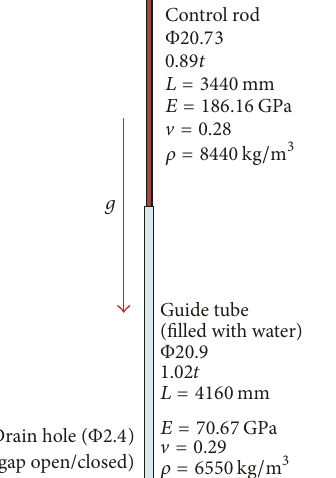
Figure1:Simplemodeldescriptionforthecontrolrodandtheguide